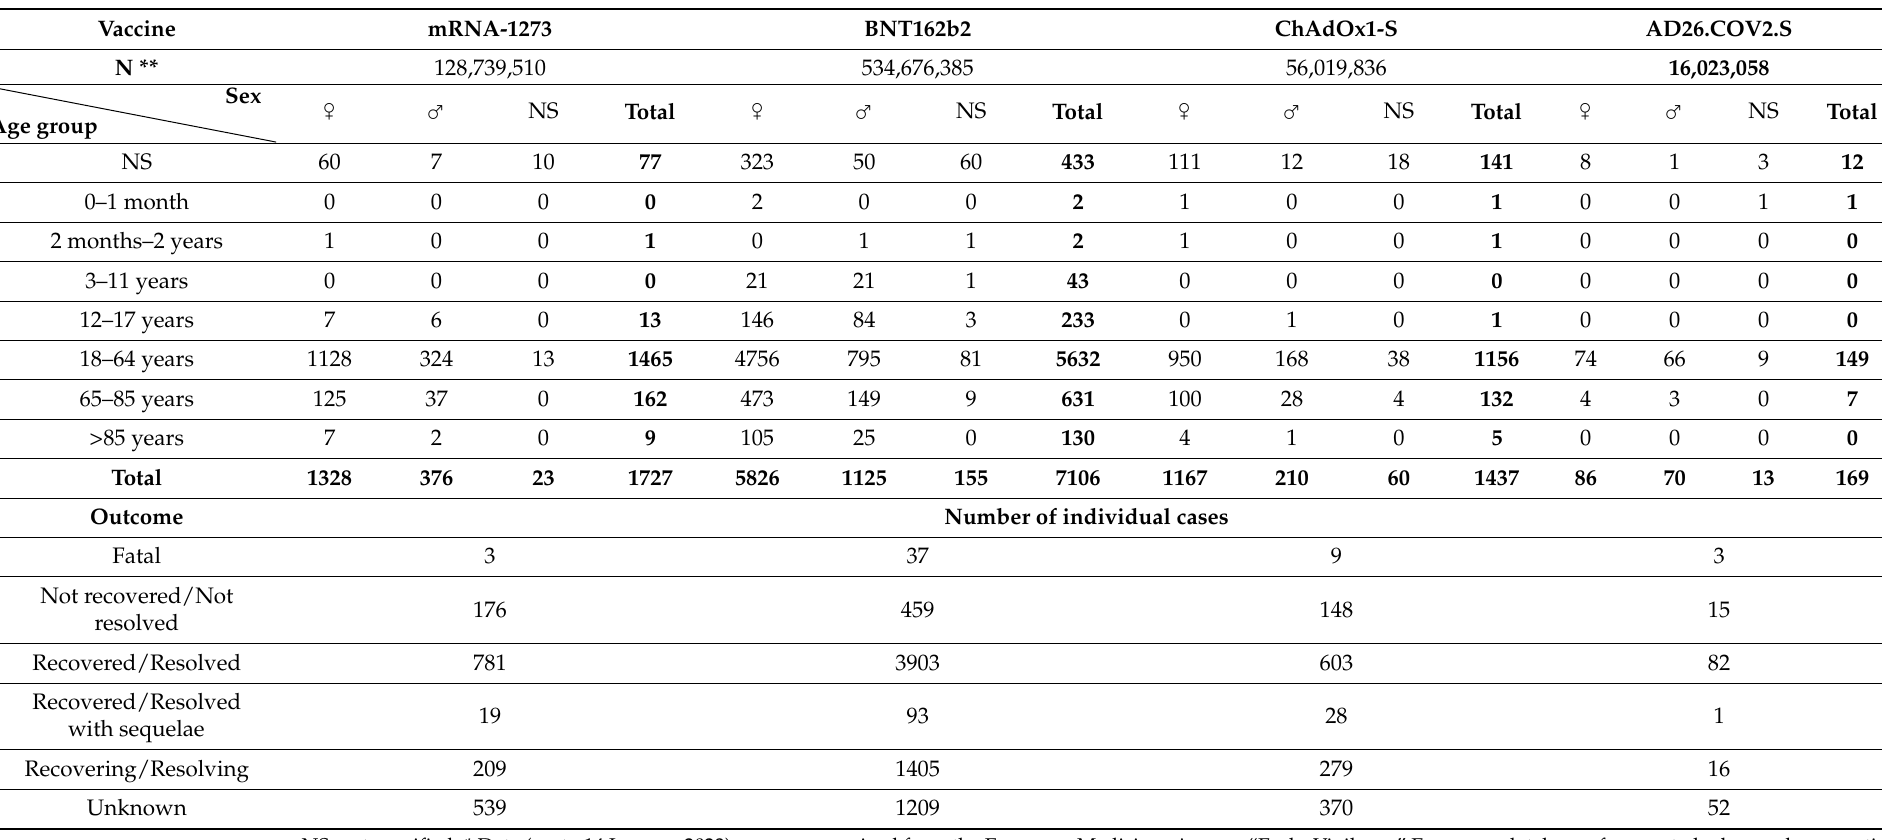
Table 1. Description of anaphylactic reaction cases post-COVID-19-vaccination reported by EudraVigilance from week 52, 2020 to week 2, 2023